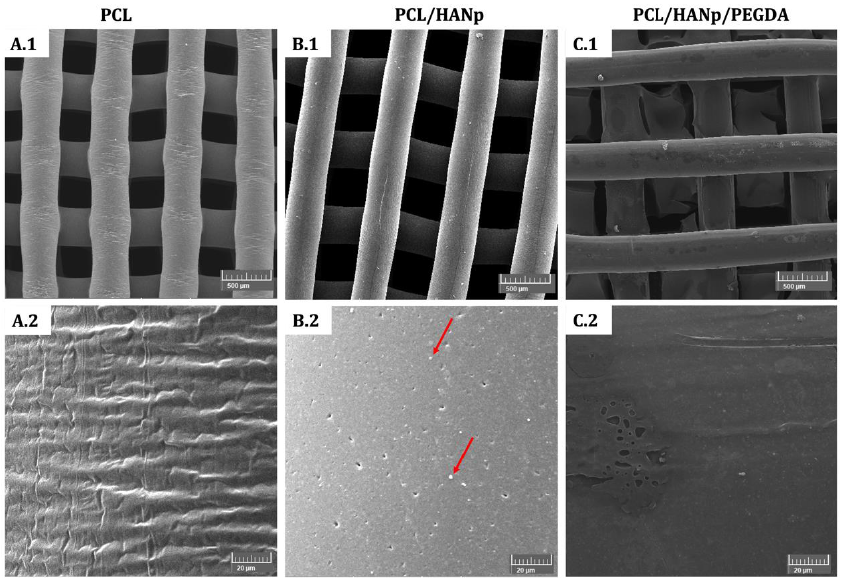
Figure 6. SEM images of PCL, PCL/HANp and PCL/HANp/PEGDA scaffolds. The red arrows show the presence of hydroxyapatite nanoparticles in the sample. Magnification: ( A.1 – C.1 ): 50× and ( A.2 – C.2 ): 1000×.